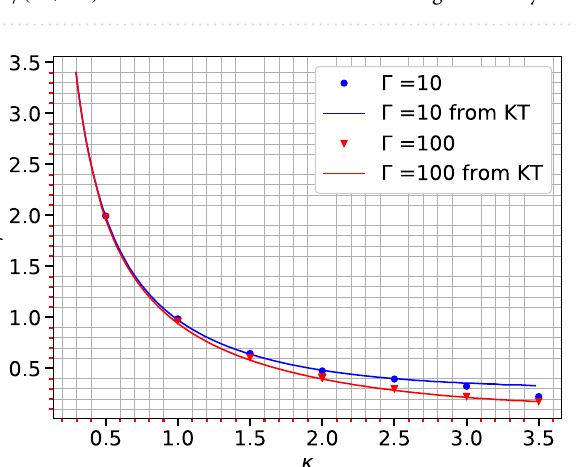
Figure 3. Sound speed ( c s ) with ka ws for different Ŵ and κ in a 3D system. The inverted triangles represent